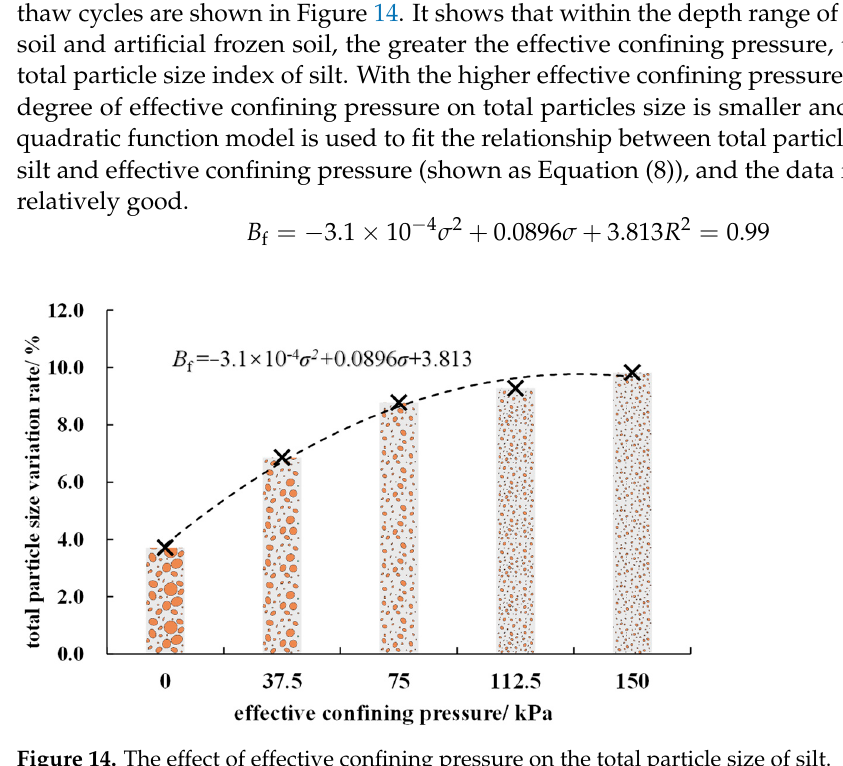
(10) Figure 15. The effect of effective confining pressure on the total particle shape of silt. 4.3.2. Freezing Temperature Under the condition of vertical confining pressure 150 kPa, effective confining pres- sure 75 kPa, and relative bulk density 0.827, the total particle size index values of silt with 20 freeze–thaw cycles at different temperatures are shown in Figure 16. It shows that within the temperature range of natural frozen soil and artificial frozen soil, the freezing temperature and the total particle size index of silt are roughly linearly correlated. The total particle size index of silt linearly increases with the decrease of freezing temperature. Linear fitting is performed on total particle size index of silt and freezing temperature (shown as Equation (11)), and the data fitting effect is relatively good.